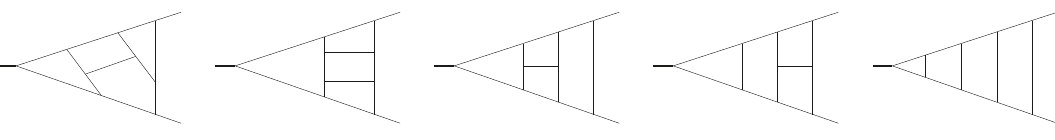
Figure 1 . A covering set of top-level integral topologies which, via edge contraction, generate the topologies of the ninety-nine irreducible planar four-loop form factor